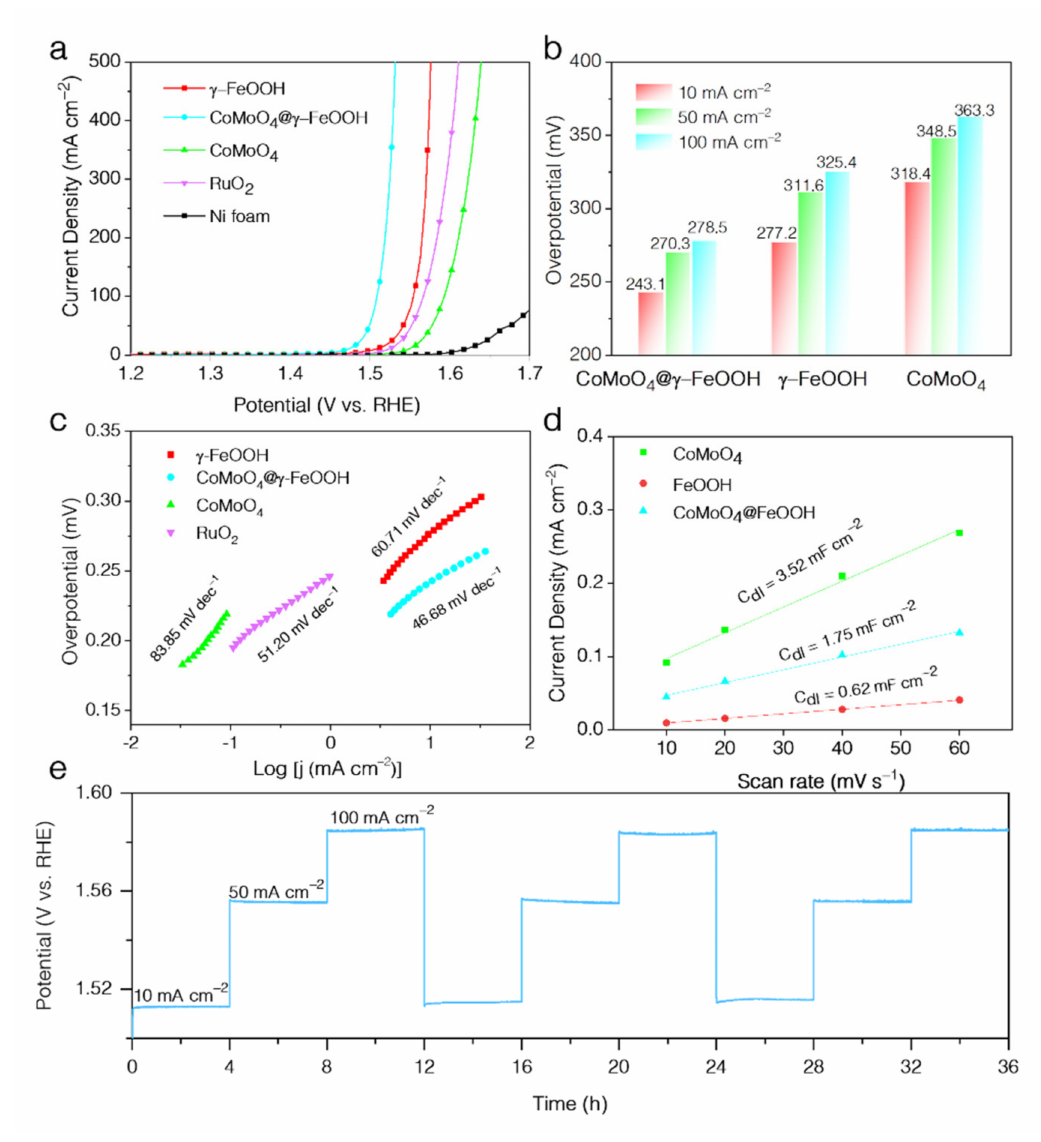
Figure 4. ( a ) LSV curves of CoMoO 4 , CoMoO 4 @ γ -FeOOH, γ -FeOOH, RuO 2 , and Ni foam in 1.0 M KOH. ( b ) Comparison of the overpotentials at 10 mA cm − 2 , 50 mA cm − 2 , and 100 mA cm − 2 for CoMoO 4 , CoMoO 4 @ γ -FeOOH, and γ -FeOOH. ( c ) Tafel plots of CoMoO 4 , CoMoO 4 @ γ -FeOOH, γ -FeOOH, and RuO 2 . ( d ) CV current density versus scan rate of CoMoO 4 , CoMoO 4 @ and γ -FeOOH. ( e ) Durability test of CoMoO 4 @ γ -FeOOH in 1.0 M KOH at constant 10 mA cm − 2 , 50 mA cm − 2 , and 100 mA cm − 2